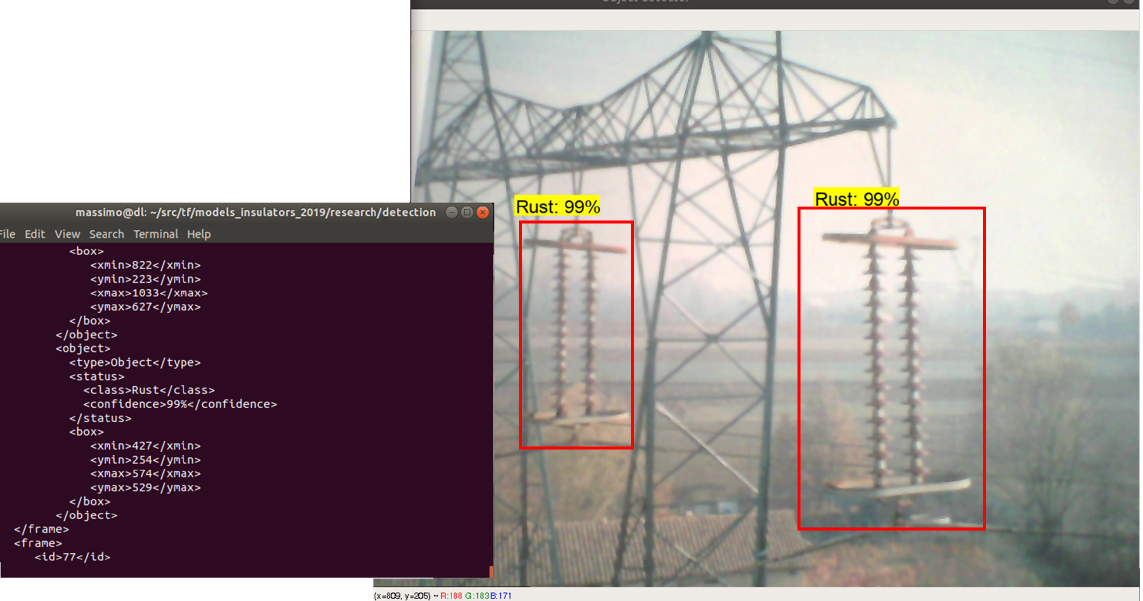
Figure 5. A screenshot of the output provided by the Python